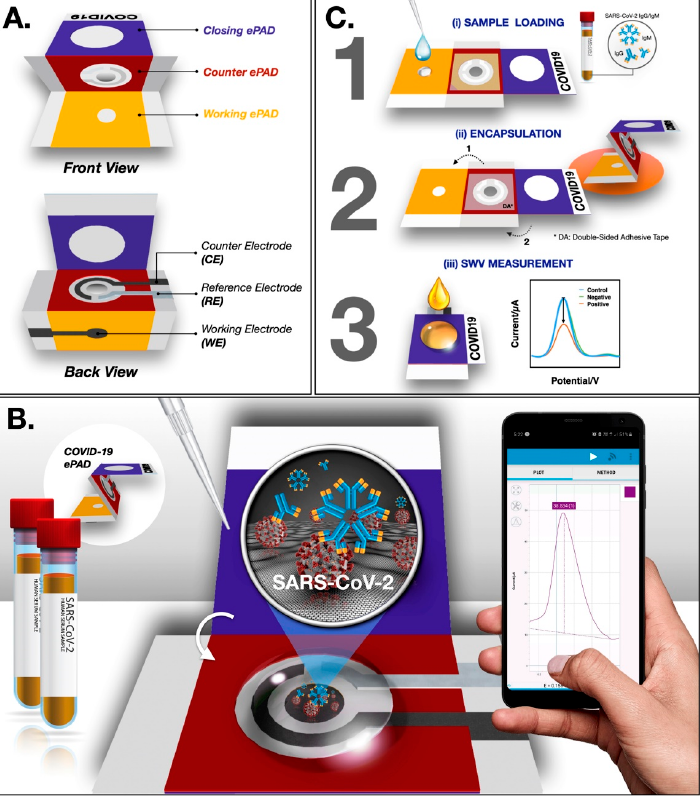
Figure 6. Schematic representation of ePAD fabrication and operation ( A ) Design of the ePAD ( B ) Interface design between ePAD and mobile phone ( C ) Operational schematic of the ePAD. Reproduced with permission from Ref. [2]. Copyright 2021Elsevier.